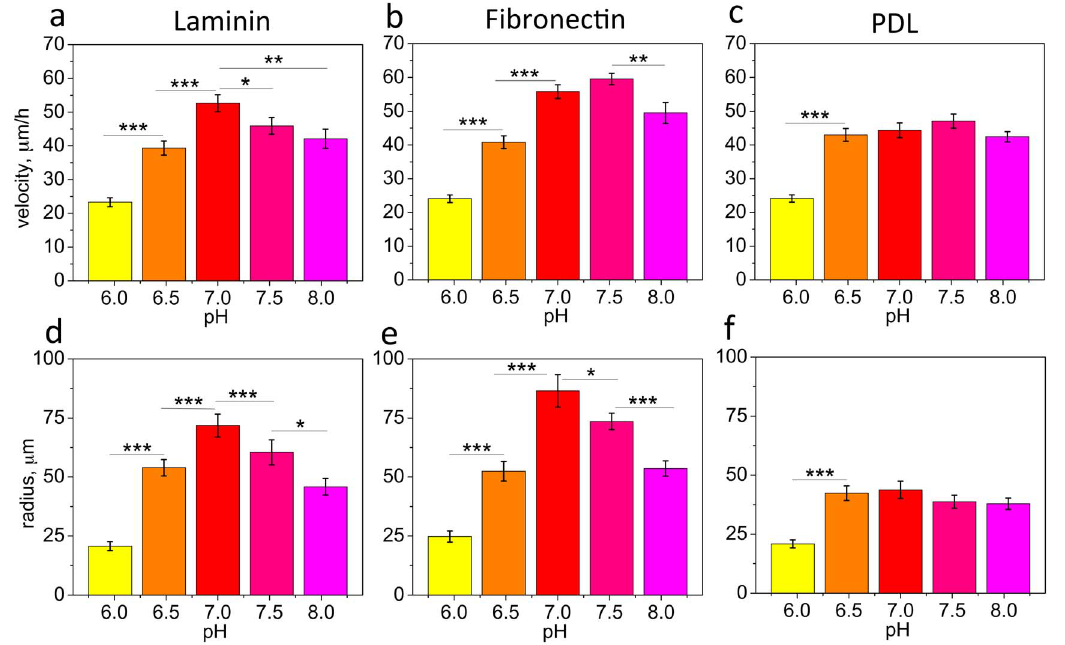
Figure 1. Migration velocity and migration radius of OPCs decreases at acidic pH. ( a, d ) laminin (10 m g/ml), ( b, e ) fibronectin (10 m g/ml), and ( c, f ) PDL surfaces (50 m g/ml). Shown are mean values for N=60 cells per pH condition. ( a–f ) Error bars are SEM; * p , 0.05, ** p , 0.01, *** p , 0.001. Colors correspond to cell media pH, representing schematically the colors on a pH indicator strip. OPC population compared to no gradient condition, at pH 7.0.